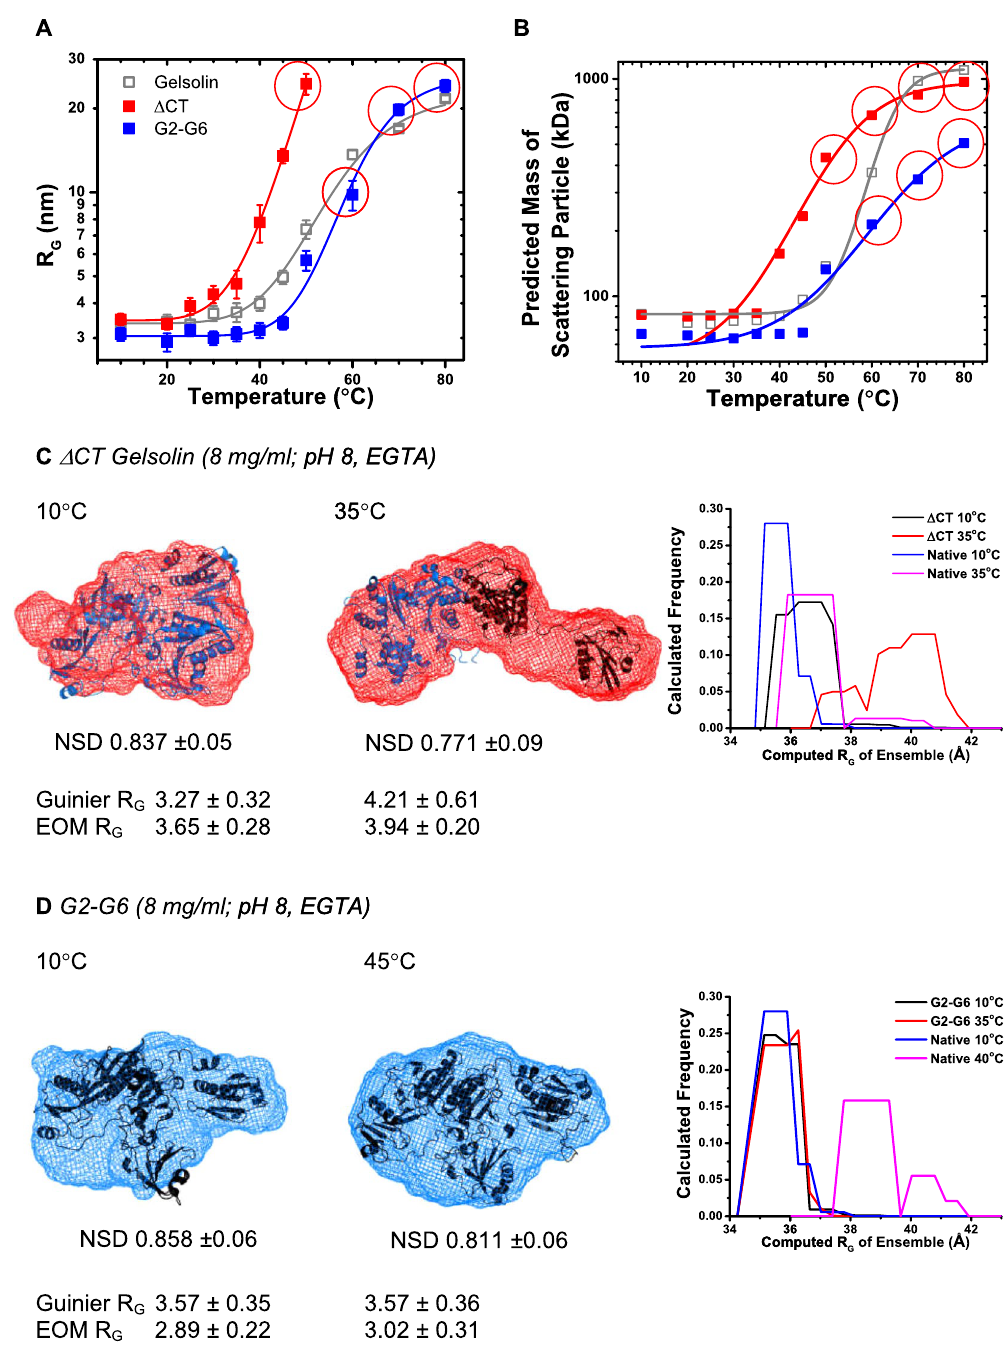
Figure 5. ( A ) The variation in the SAXS data based estimated R G values of Δ CT and G2–G6 gelsolin are shown as a function of time relative to the values computed for full-length gelsolin. ( B ) Variation in the molecular masses of the Δ CT and G2–G6 gelsolin estimated using I 0 values from Guinier analysis are compared with those estimated for full-length gelsolin. ( C ) SAXS data based dummy residue models of Δ CT gelsolin at 10 and 35 °C (red mesh). Crystal structures are placed inside as described in main text. ( D ) SAXS data based dummy residue models of predominant scattering shape of G2–G6 gelsolin in Ca 2 + free buffer having pH 8 at 10 and 45 °C (blue mesh). The right panels in both ( C , D ) segments show the variation in the R G values of the conformations assessed by EOM